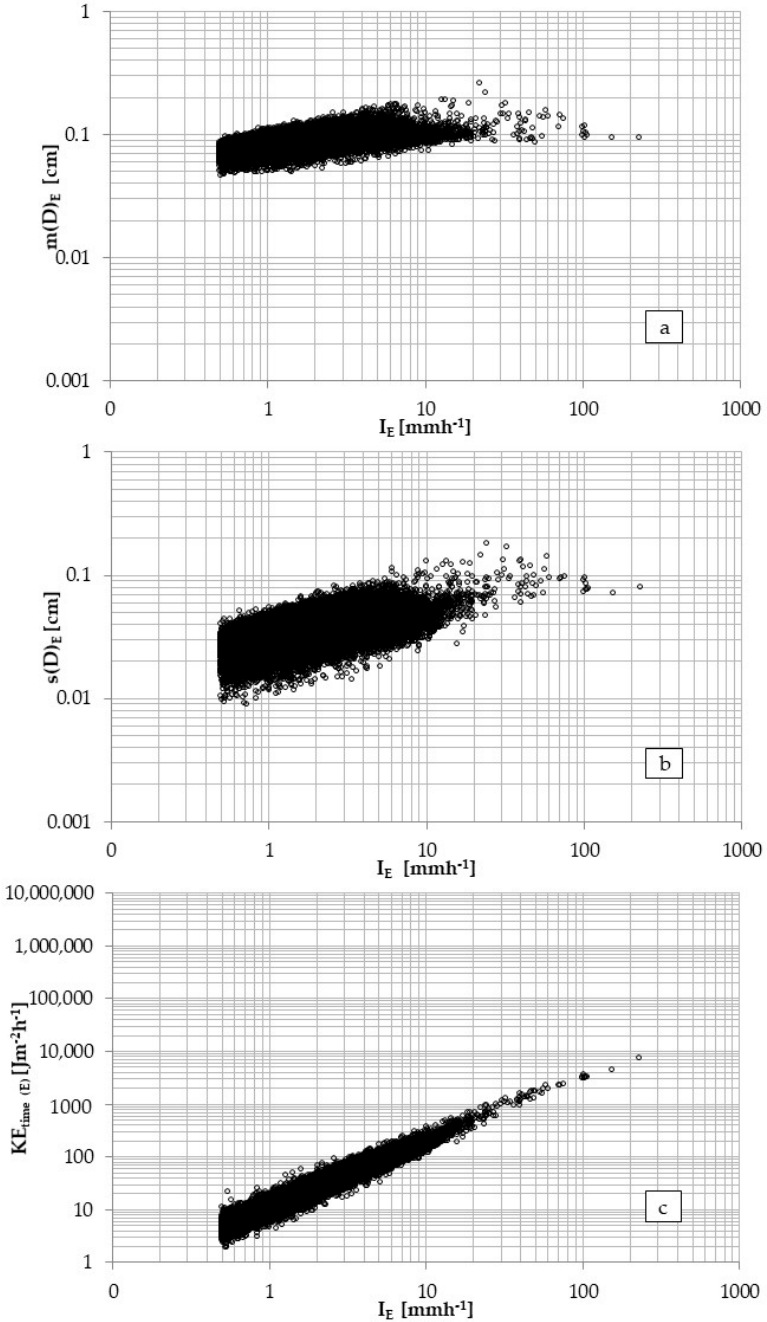
Figure 7. The mean diameter m(D) E and standard deviation s(D) E of DSDs are represented against the rainfall rate ( a and b , respectively) after the elimination of DSD measurements distorted by environmental factor effects. Kinetic energy rate (i.e., KE time(E) ) against rainfall intensity I E after the elimination of DSD measurements distorted by the environmental factor effects, panel c .